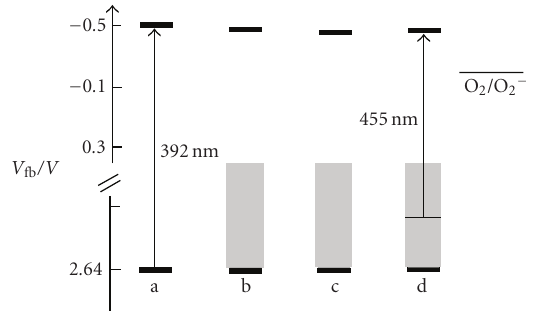
Figure 1: Electrochemical potentials (versus NHE) of band edges of three N-doped TiO 2 s: (a) TiO 2 , (b) TiO 2 –N/1, (c) TiO 2 –N/2, (d) TiO 2 –N/3. Shaded areas denote surface states; the oxygen redox po- tential at pH 7 is also shown. Reproduced with permission from [16]. Copyright Wiley-VCH Verlag GmbH & Co.